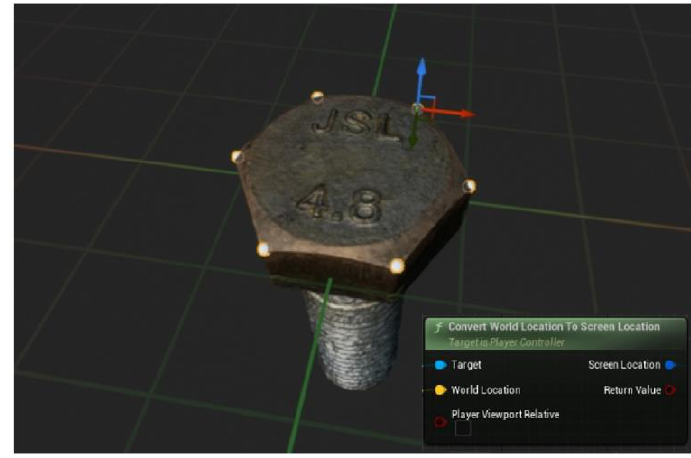
Figure 9. Marker objects fixed on the bolt model.